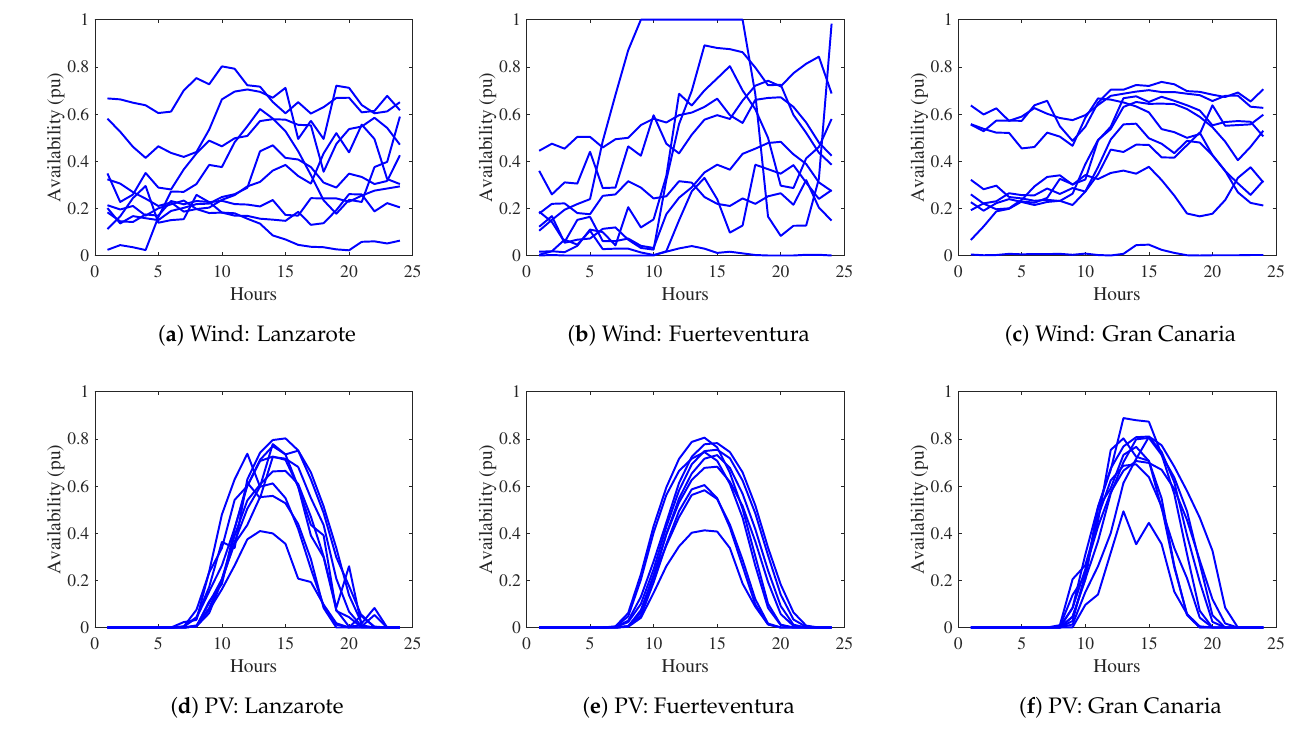
Figure 3. Wind and solar PV availabilities. Figure 4 represents the hourly demand for each characteristic day in each island.